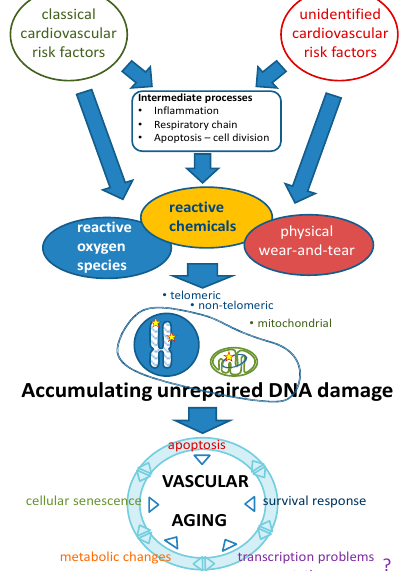
Figure 1. Etiology of vascular aging based on genomic instability as a causal factor. Classical and unidentified risk factors contribute to various types of DNA lesions. Unrepaired lesions accumulating during life lead to a growing set of pathophysiological changes that, either independently or in mutual interaction, lead to progressive vascular aging. The putative role of transcriptional problems or mutations herein needs to be established. The survival response may have beneficial (increased Nrf2-regulated antioxidants) as well as detrimental (decreased IGF-1 signaling, pro-inflammatory status) effects (see text and Ref. [8]).